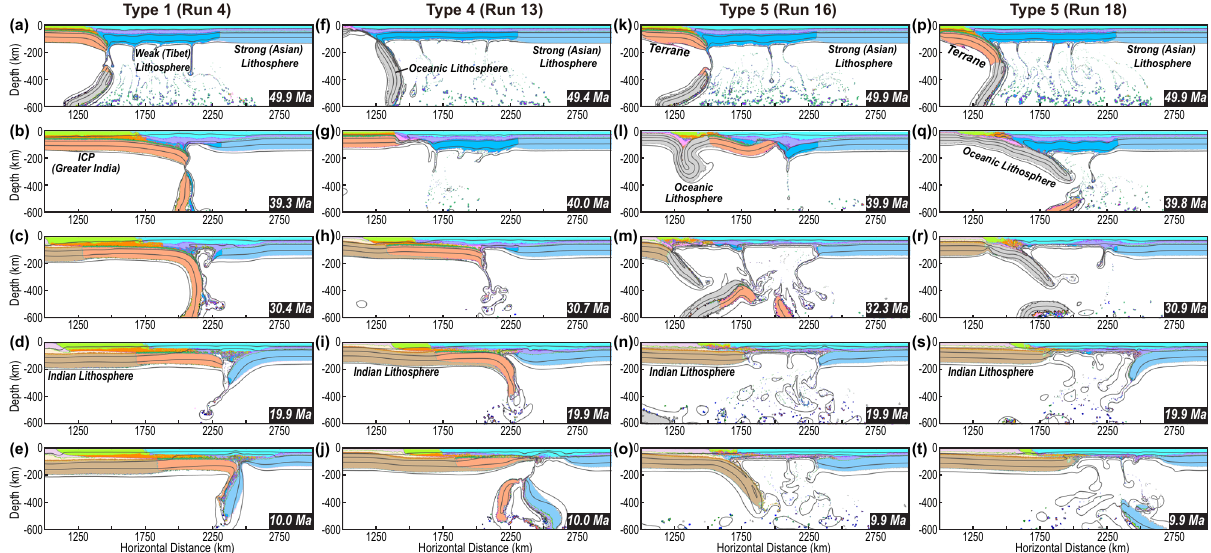
Fig. 4 | Typical geodynamic evolution seen in numerical models. In Type 1 models (Fig. 3a): a , b fl at subduction develops once the former oceanic slab separates with the following continental block. (c) the fl at slab bends downward when it collides with the strong overriding plate, and later, its deeply subducted portion breaks up with the shallow one. d , e the remaining fl at slab bulldozes the lowerlithosphere(belowcrust)ofthestrongoverridingplateintothedeepmantle. In Type 4 models: f the oceanic portion develops steep subduction; and g – j the